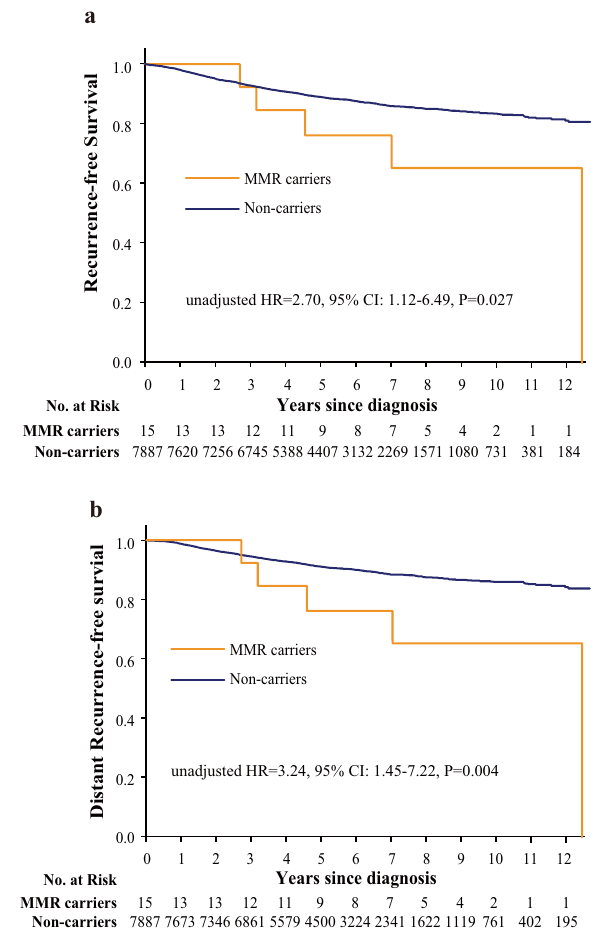
Fig. 1 Kaplan – Meier survival analyses according to germline variants status in MMR genes. a and b show recurrence-free survival and distant recurrence-free survival, Data are analyzed for statistical signi fi cance using univariate Cox proportional hazards models. Two-sided P values < 0.05 were considered to be statistically signi fi